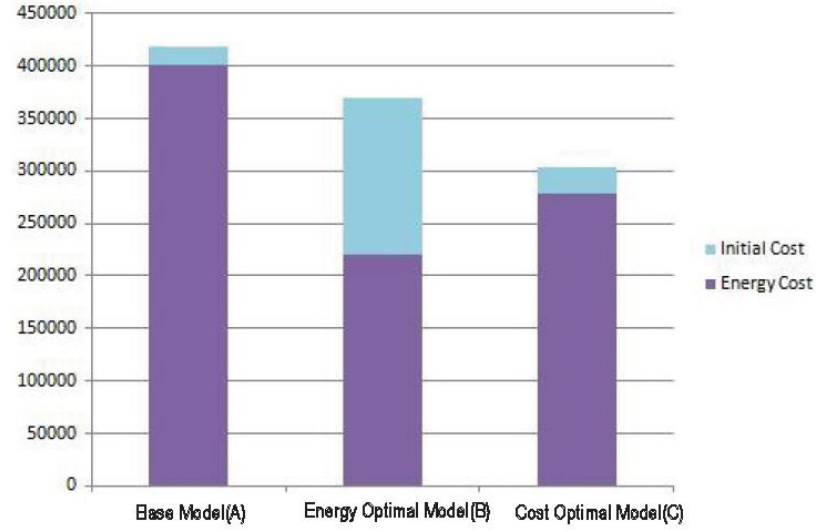
Figure 12. Comparison Results of Alternatives. Table 5. Results of Case Study.